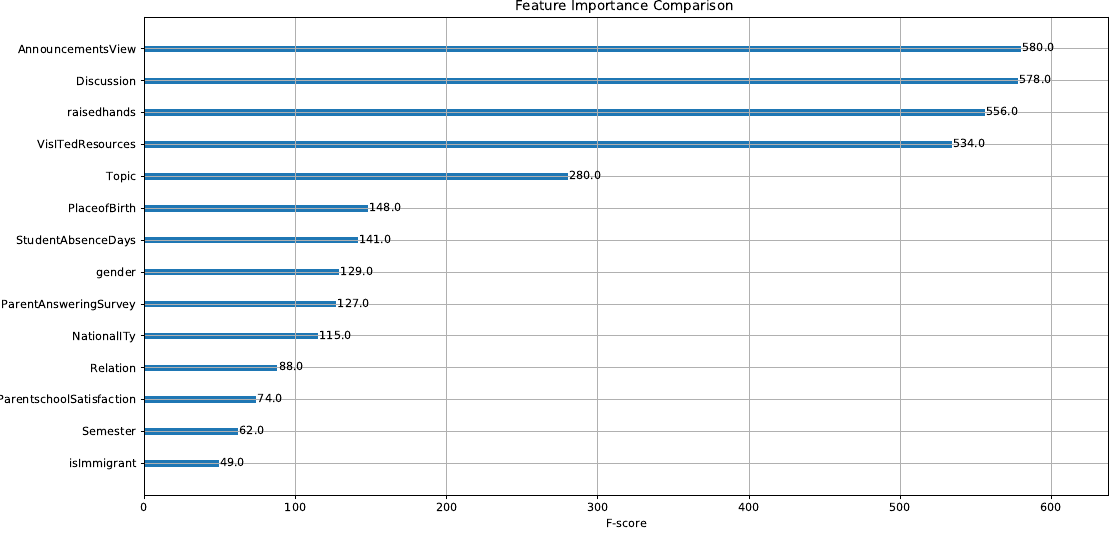
Figure 8. Feature importance comparison of student